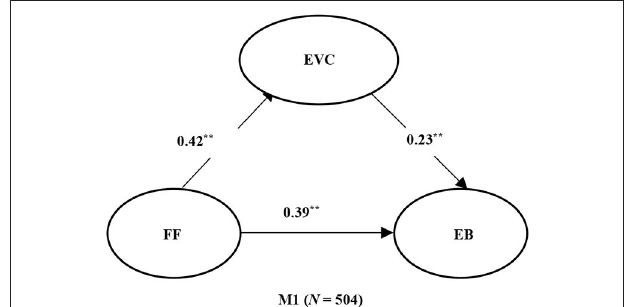
FIGURE 1 | Path relationship diagram of Mediation model. ** p < 0.01. FF, family function. EVC, exercise value cognition; EB, exercise behavior. The values in the figure are standardized path coefficients.